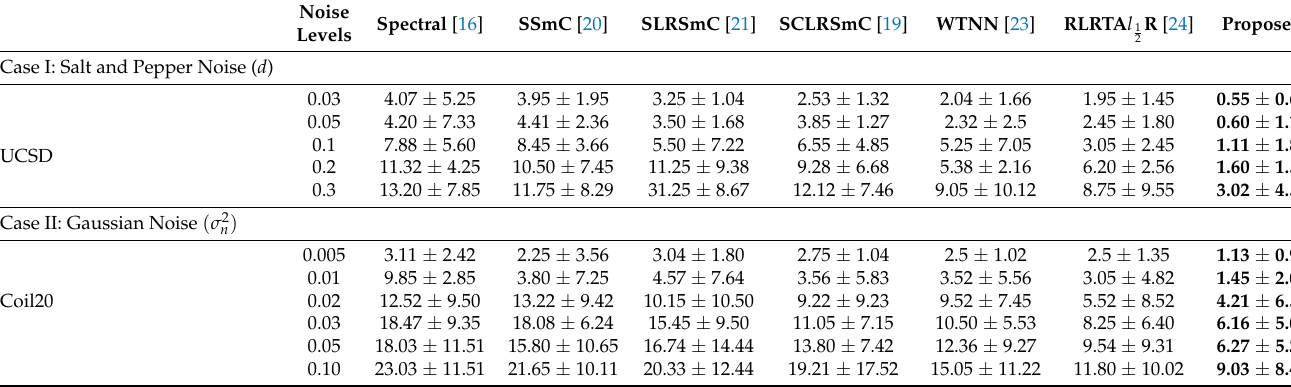
Table 2. Compared results of MCR ( m σ ) % metrics using Coil20 and UCSD datasets under various levels of salt and ± pepper and Gaussian noise. For salt and pepper noise, noise density d and for Gaussian noise, noise variance σ 2 n are added. Best values are highlighted in bold letters.